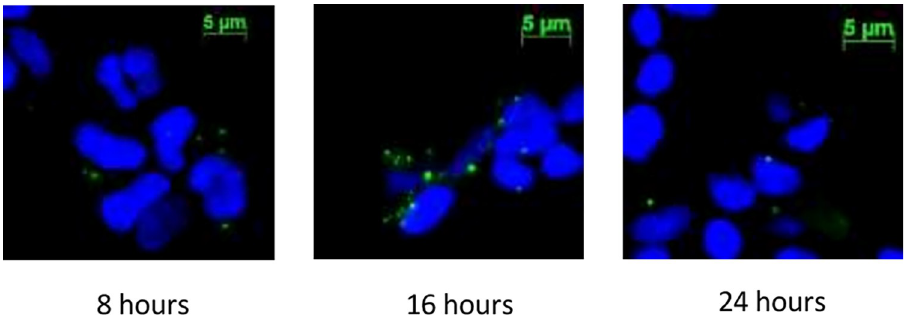
Fig 3. Cellular uptake analysis. HEK293 cells were incubated with DiO stained Tom40-exosome for 8, 16 and 24 hours. Imaged with Fluorescence microscope at 400X total magnification. DiO stained Tom40-exosomes were seen as green fluorescent staining. All nuclei were counterstained with DAPI